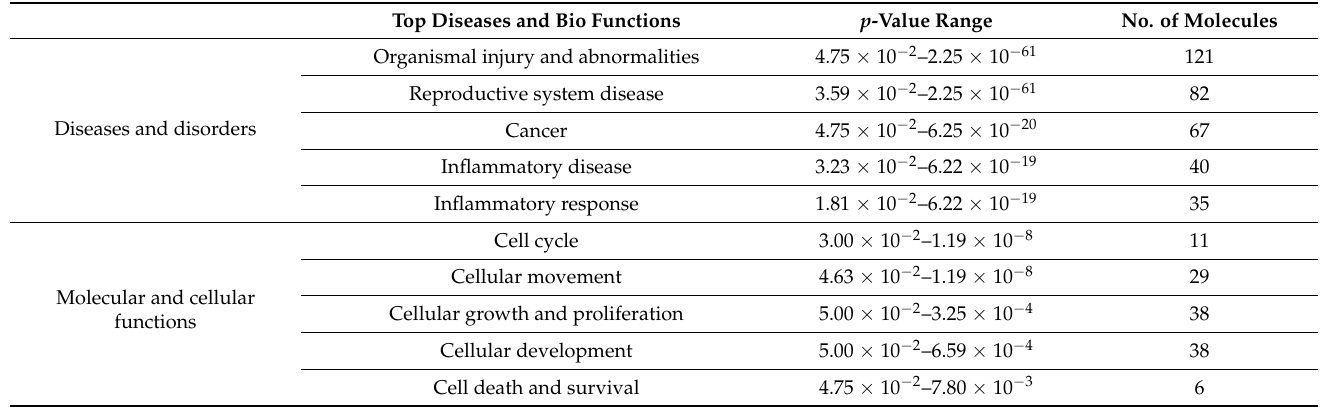
Table 4. Top diseases and bio functions related to downregulated miRNA target